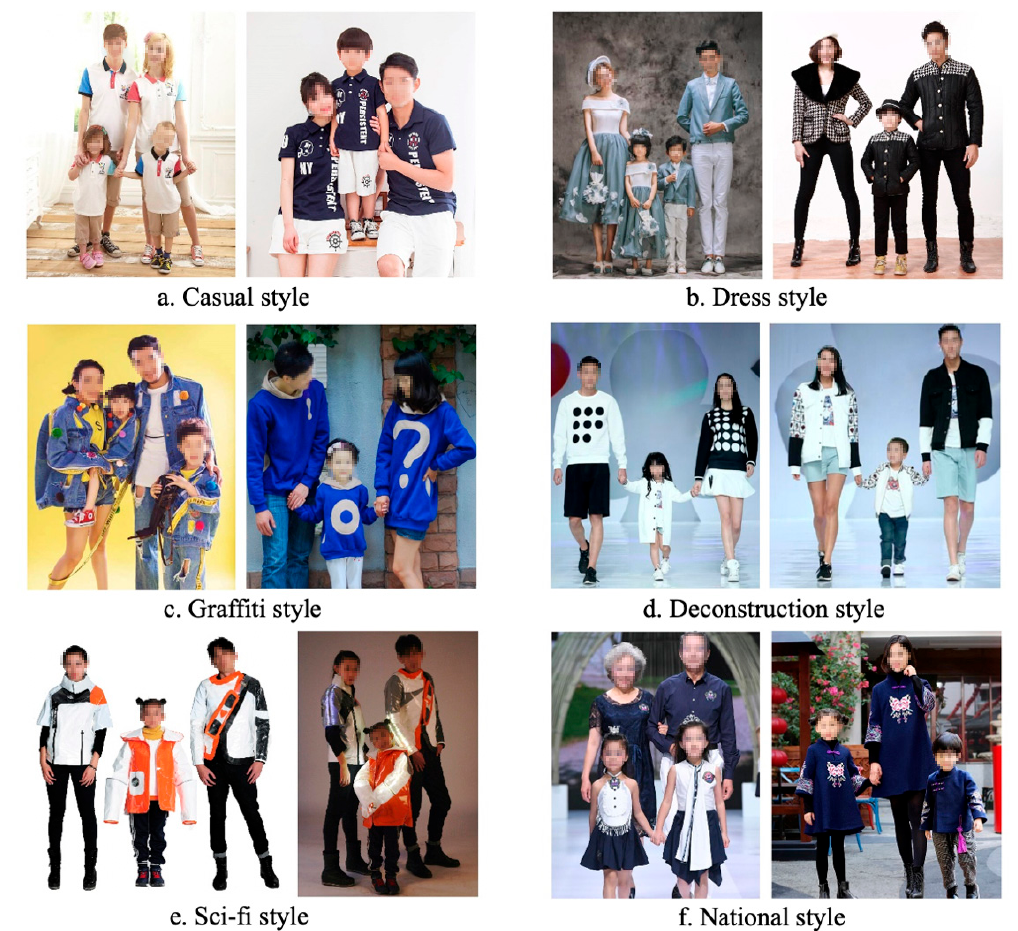
Figure 7. Categories of comparison. ( a ) Casual style, emphasizing a natural and straightforward style;